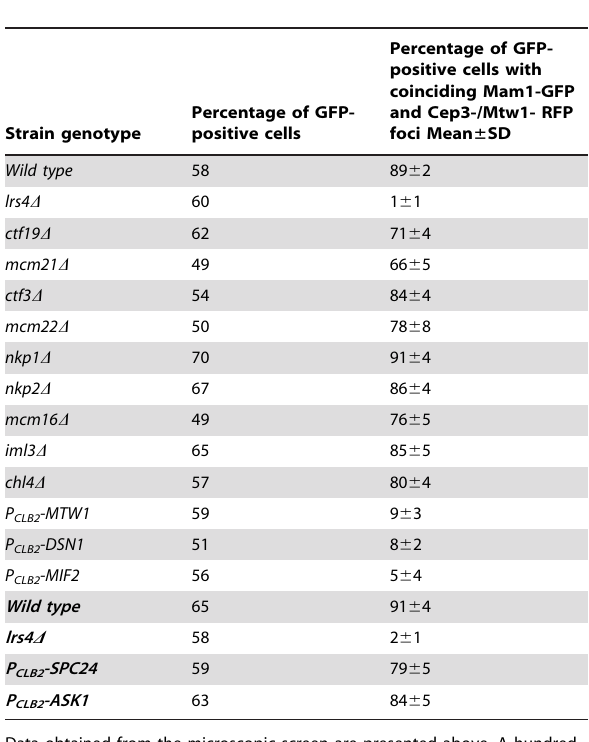
Data obtained from the microscopic screen are presented above. A hundred cells in triplicate were scored for each strain after transfer to SPM for 5–8 h. The average percentage of cells showing Mam1-GFP expression and percentage of GFP-positive cells having co-localization of Mam1-GFP foci with Cep3–RFP or Mtw1-RFP are indicated. Genotypes of Cep3-RFP and Mtw1-RFP strains are indicated in normal type and boldface